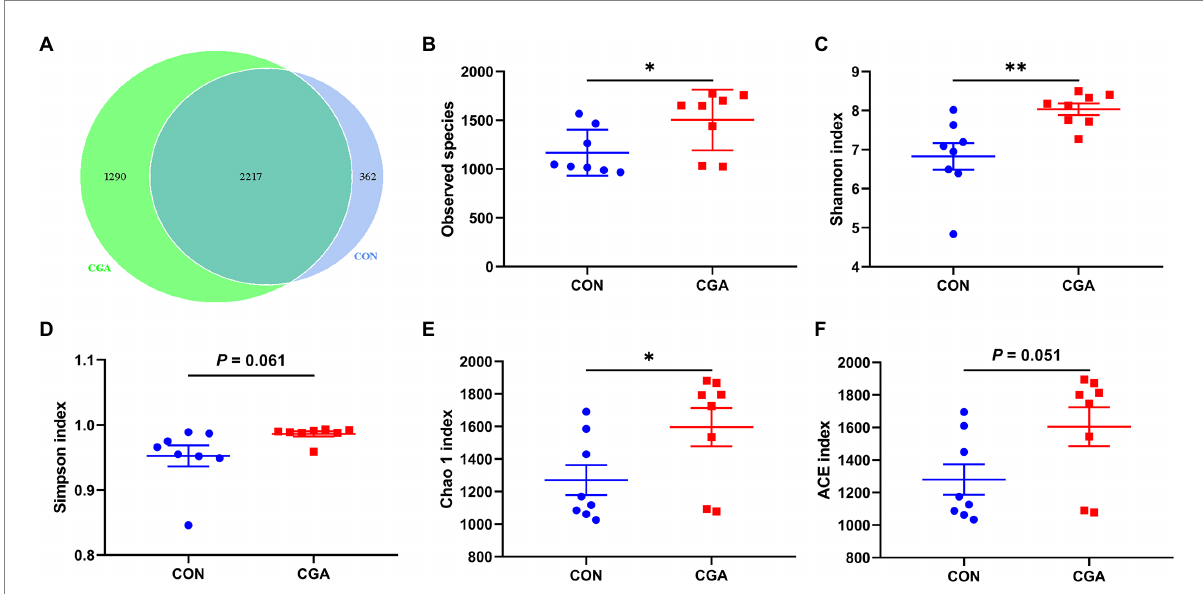
FIGURE 5 Differences on bacteria community diversity and richness between the two groups. (A) A Venn diagram generated to depict shared and nique sequences between the two groups; (B) Observed species; (C) Shannon index; (D) Simpson index; (E) Chao 1 index; (F) ACE index. CON, rabbits fed a basal diet; CGA, rabbits fed the basal diet supplemented with 800 mg/kg chlorogenic acid. Results are presented as mean and SEM ( n = 8). Significant difference was recorded by 0.01 < p < 0.05 * , p < 0.01 **